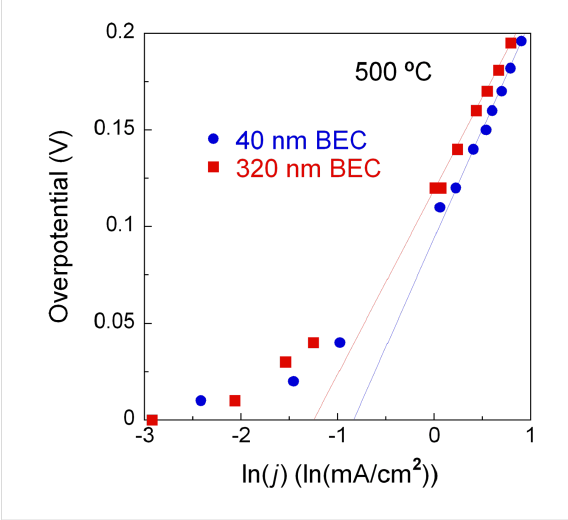
Figure 3: Tafel plots, measured at 500 °C, for the Cell-A and Cell-B. more infiltrated ALD YSZ electrolyte into the thinner BEC could have larger BEC–electrolyte contact area, referring to the cross-sectional FE-SEM imaging result of Figure 2A, than the counterpart.